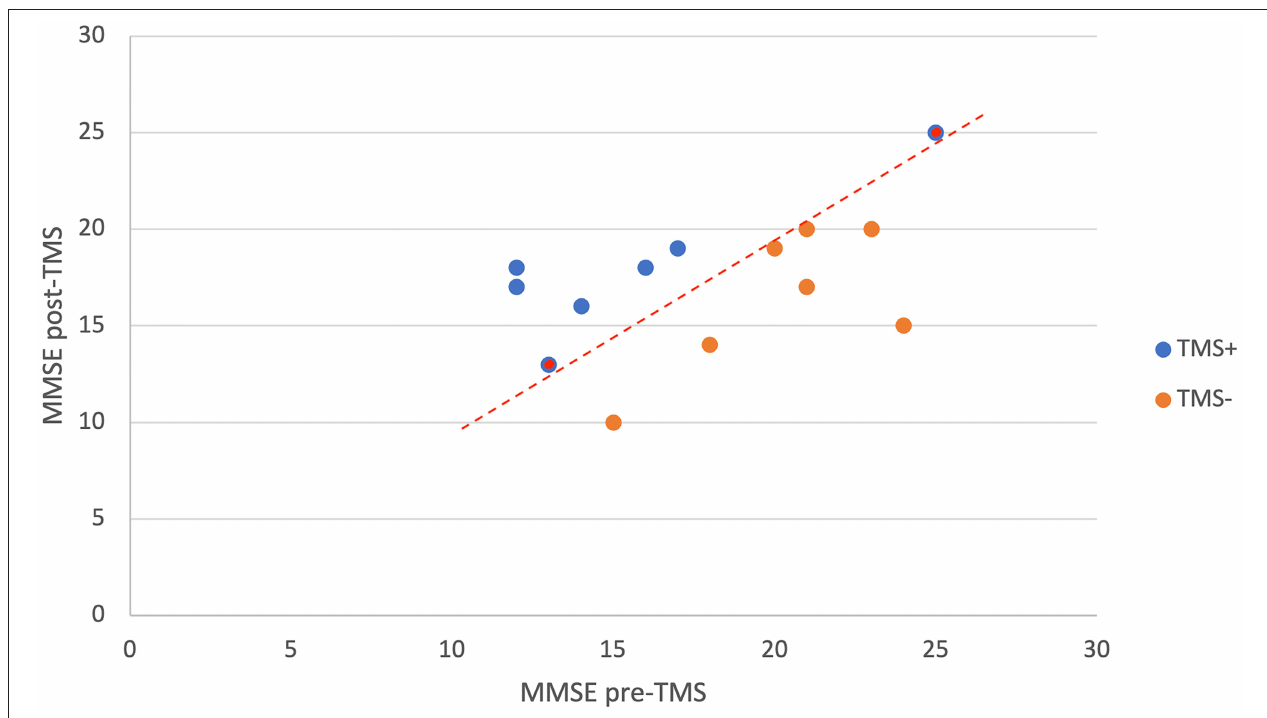
FIGURE 4 | The change in MMSE scores of TMS + and TMS- patients with the TMS application. As it is seen in the figure, these two groups can be separated from each other with the red dashed decision line. The patients with the same MMSE score post- and pre-TMS which are labeled as TMS + are represented as red dots inside